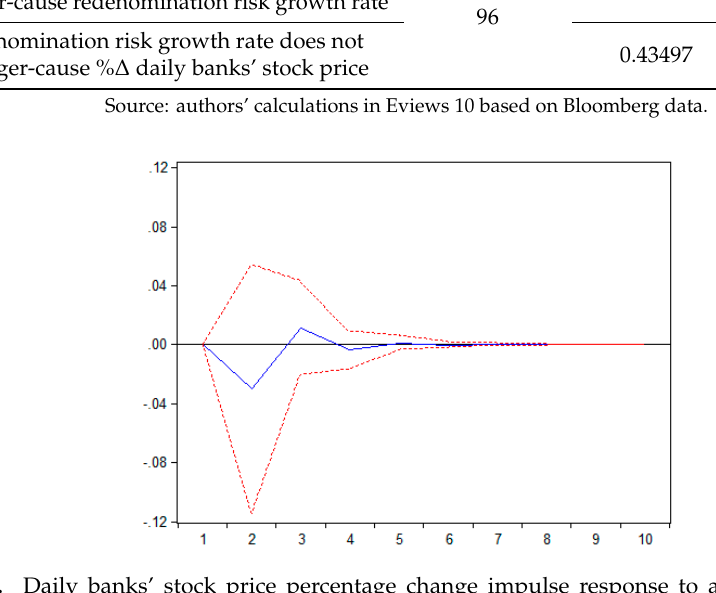
Figure 4. Redenomination risk growth rate impulse response to a unit shock of daily banks’ stock price percentage change. Source: authors’ calculations in Eviews 10 based on Bloomberg data. Even if two graphs show a similar shape, the values scale highlights that the response to the redenomination risk growth rate has a higher impact on the process.